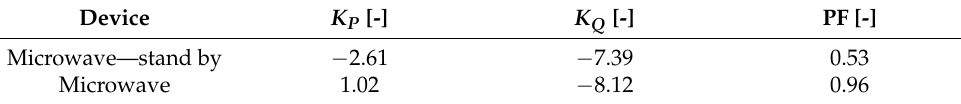
Table 8. Comparison of the frequency sensitivity coefficient of microwave—different operation conditions.